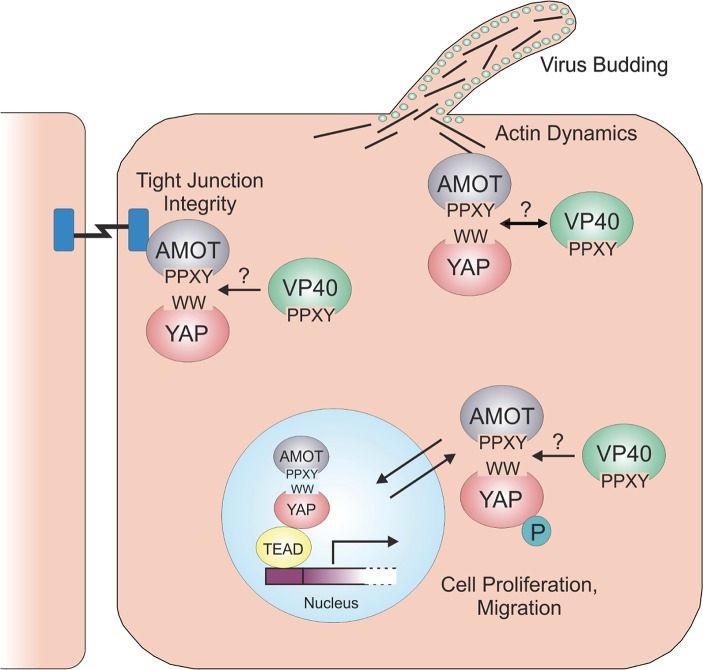
Working model of modular competition between filovirus VP40 and Hippo pathway components YAP and AMOT.Potential competition (?) between the PPxY motifs of filovirus VP40 and those of AMOT for binding to WW-domains of YAP (and/or TAZ) may affect cellular processes including, actin dynamics and filopodia formation, tight junction formation and integrity, and upregulation of genes involved in cell proliferation and migration.